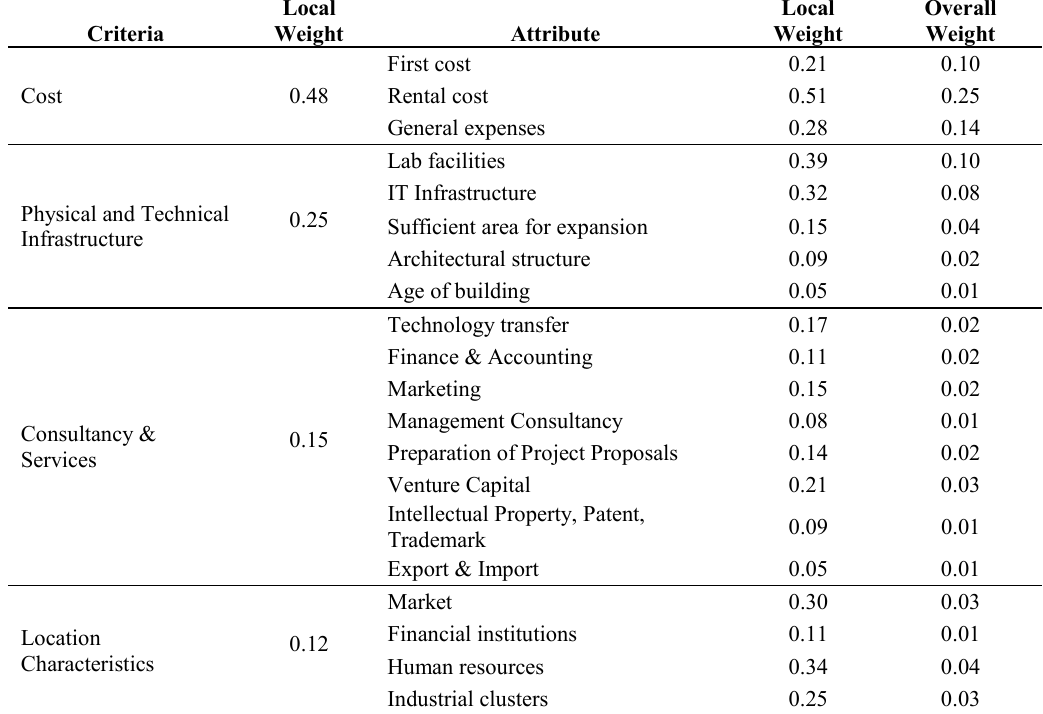
Table 2. Weights of evaluation